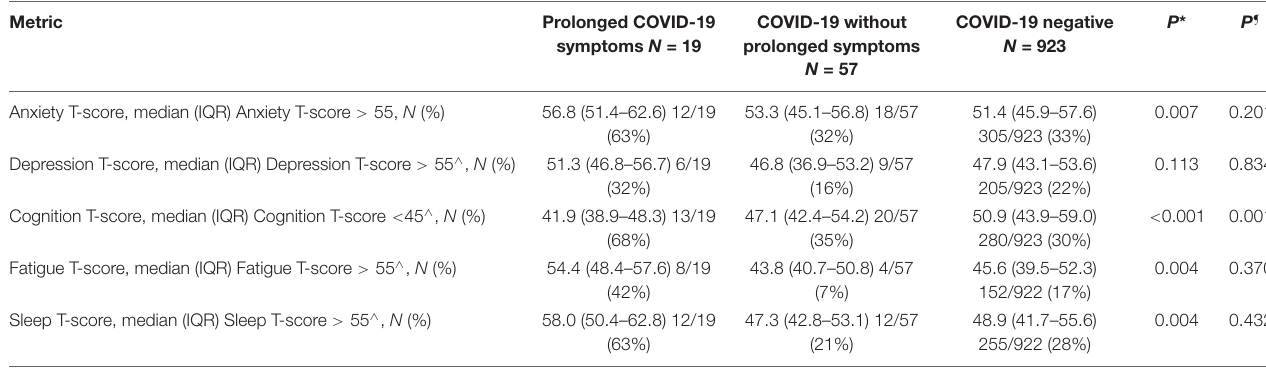
TABLE 3 | Neuro-QoL T-scores by COVID-status ( N = 999). Metric Prolonged COVID-19